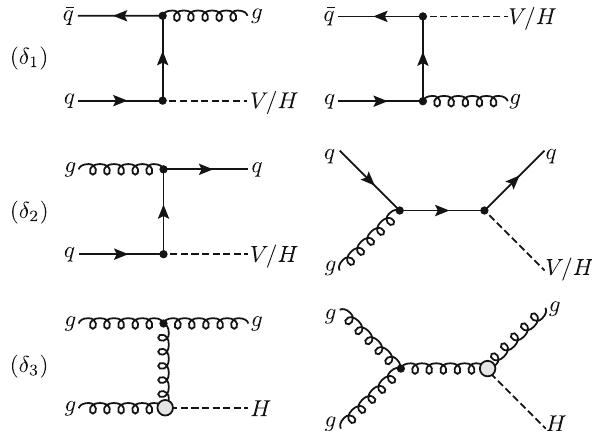
Fig. 1 Partonic processes considered in this